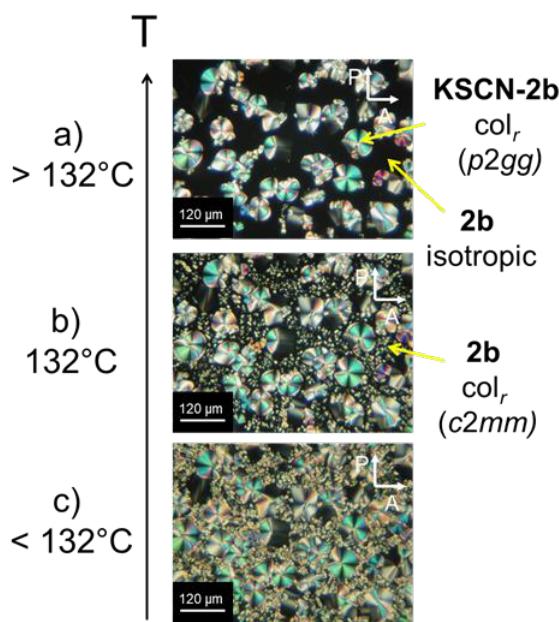
Figure 4. KSCN-2b sample in a polyimide coated cell after cooling down from the isotropic melt. Above 132 °C ( a ) the macroscopic segregation of the complex (texture) and isotropic free crown 2b (dark parts) can be seen clearly. By cooling down (top to bottom) the isotropic-columnar phase transition ( b ) of 2b at 132 °C can be observed. In ( c ), the columnar phase of KSCN-2b and neat 2b coexist.